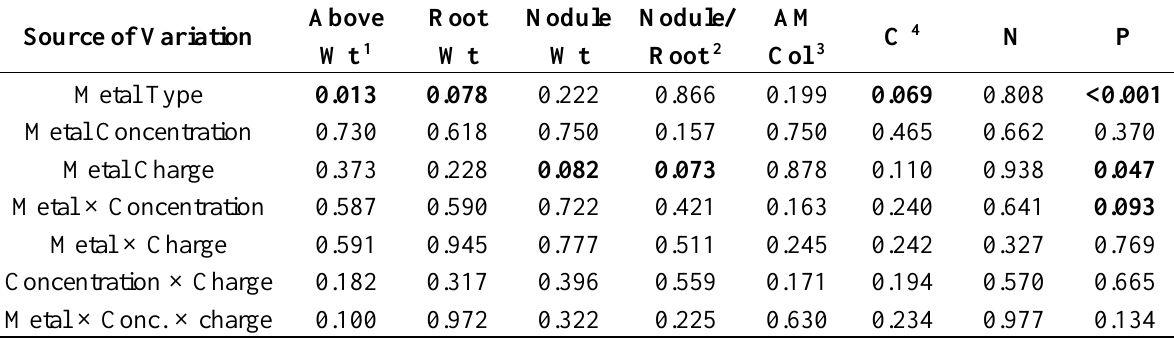
Table 1. Results of three-way ANOVA using the general linear model for effects of nanoparticle concentration and charge on plant growth performance. p values are shown where significant differences ( p < 0.1) are in bold. Note: nutrient contents refer to leaf tissue only. (Above Wt = weight of plant tissue above ground, Root Wt = weight of roots, Nodule Wt = weight of nodule, Nodule/Root = nodule weight per root mass, AM Col = arbuscular mycorrhizal colonization).